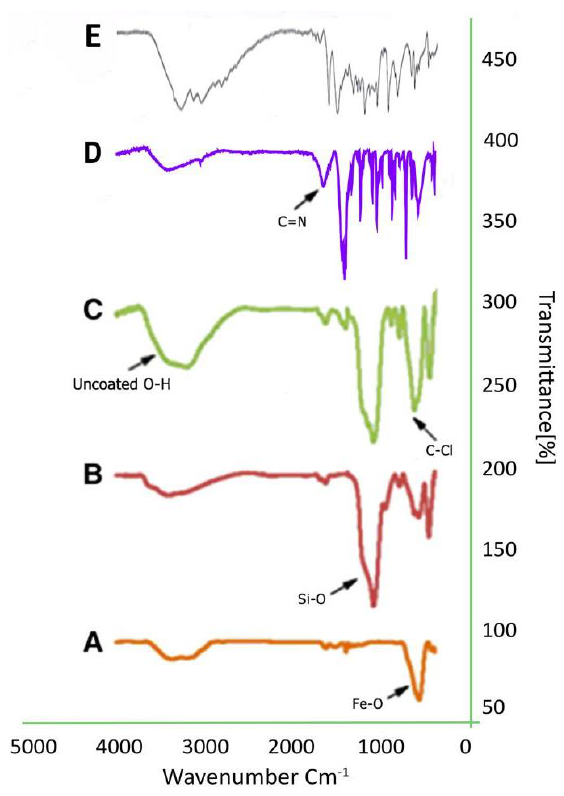
Figure 1. FT-IR spectra of five steps of preparation of the nano-catalyst ( A – E ).